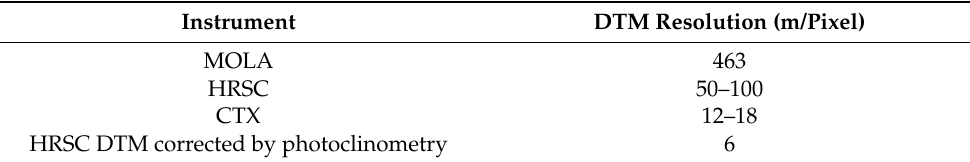
Table 1. Summary of the resolution of the different DTM sources used in this paper. Instrument